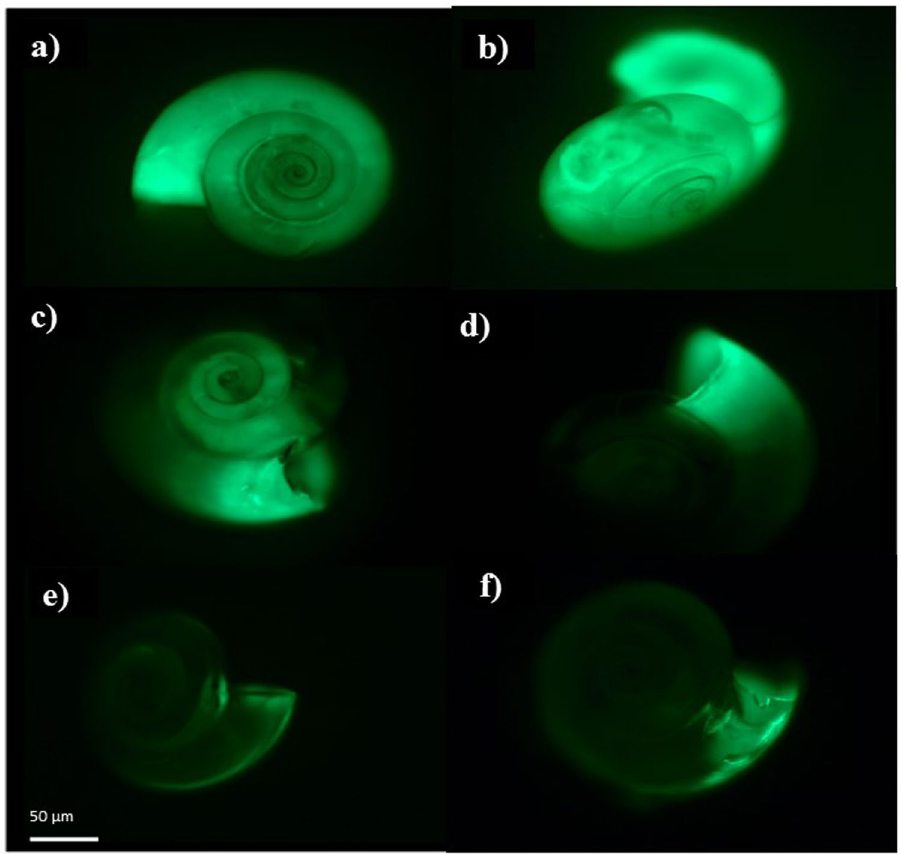
Figure 5. Calcification patterns in Limacina helicina depicted as the proportional fluorescent glow of incorporated calcein dye under the epifluorescence microscope. The greatest extent of fluorescent glow indicates the most active calcification activity and was present in pteropods collected from Cluster Groups 3 and 4 (with Ω ar ≥ 1.2; a and b ) and occurs over the entire shell, from the protoconch to the growing edge. At lower Ω ar (Cluster Group 2; 0.8 < Ω ar < 1.2) calcification extent is reduced to more distal parts of the shell ( c and d ), while overall decline in calcification occurs in pteropods from the Cluster Group 1 (Ω ar < 0.8; e and f ) with only parts of the growing edge still showing evidence of calcification activity. Pteropods were exposed to calcein dye for 18–20 hours; the images were taken at the same magnification (10 × ) and the scale bar (50 µ m) indicates the size of the